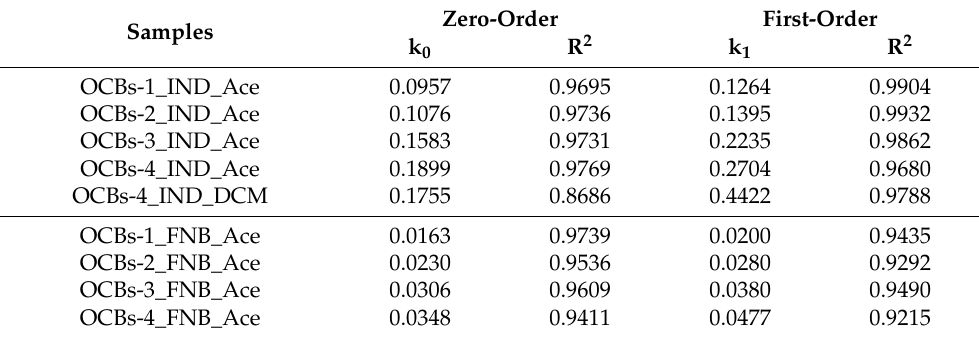
Table 1. Results of fitting the release data of IND and FNB at pH 7.0 with zero-order and first-order kinetic models.